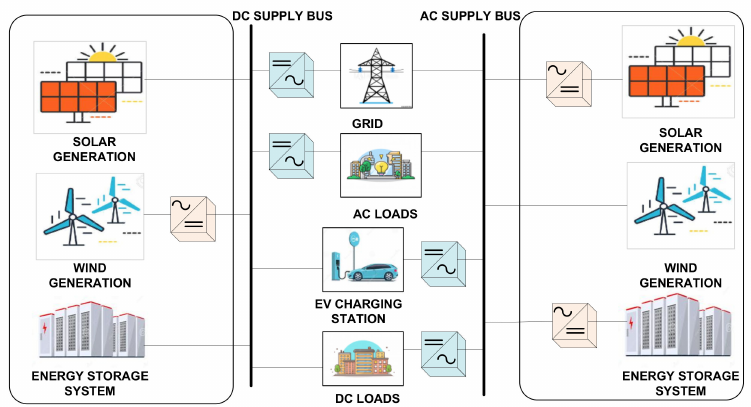
Figure 6. Structure of a hybrid